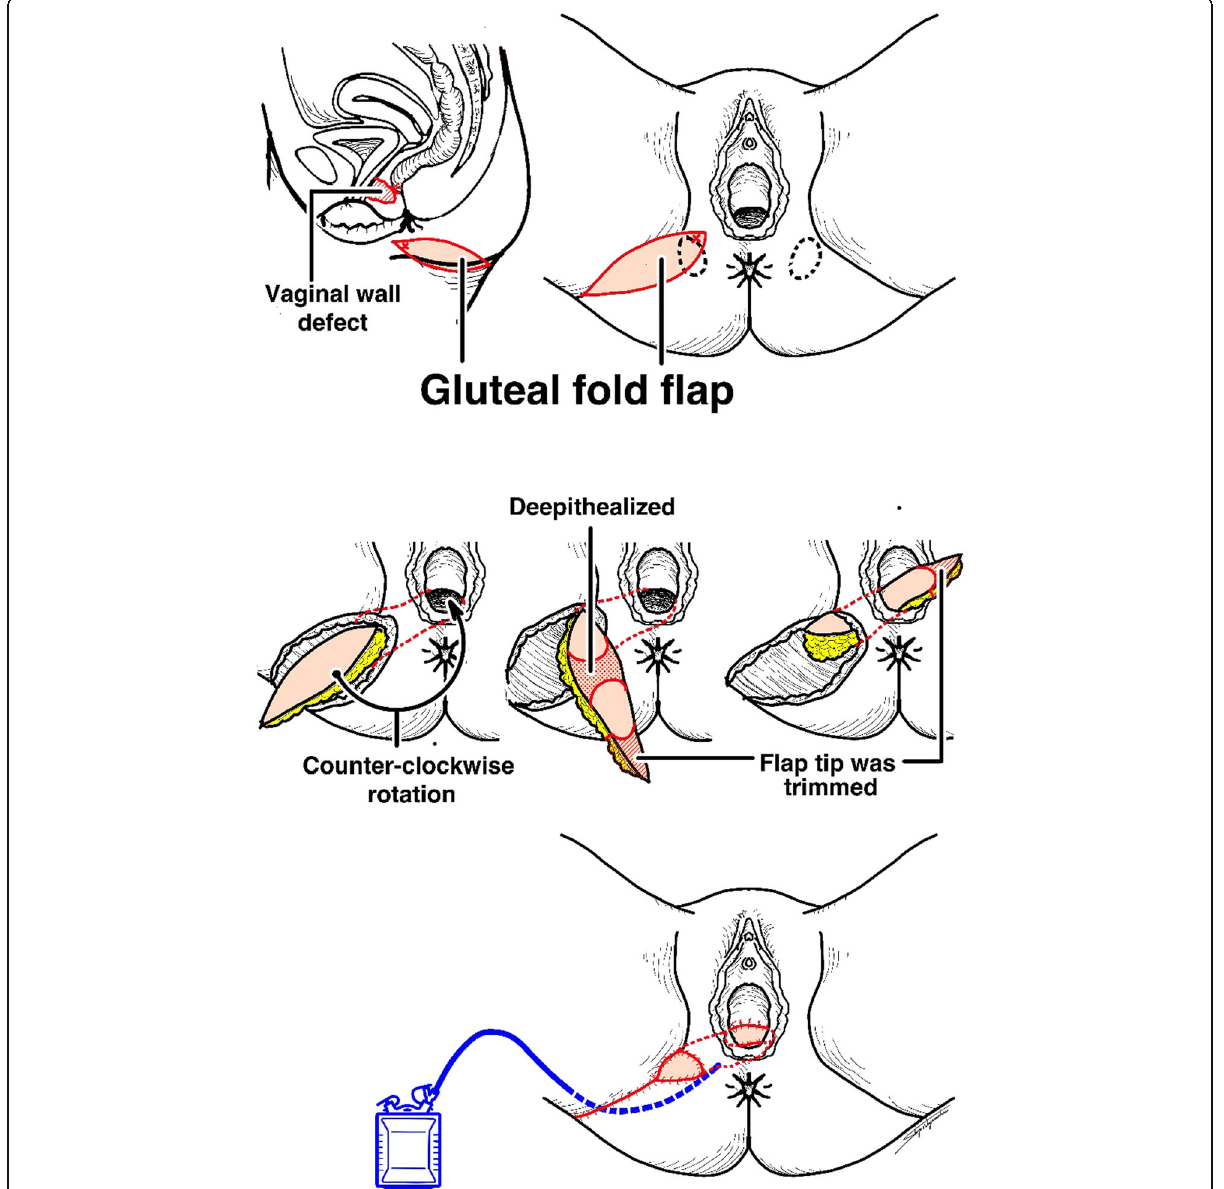
Fig. 3 The illustrations of the operative